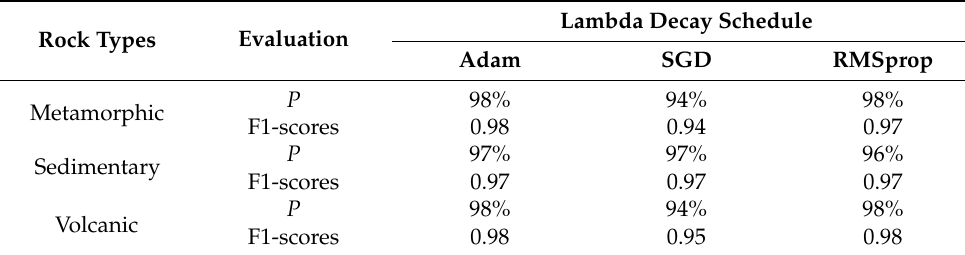
Table 3. Detailed classification results for all rock types.